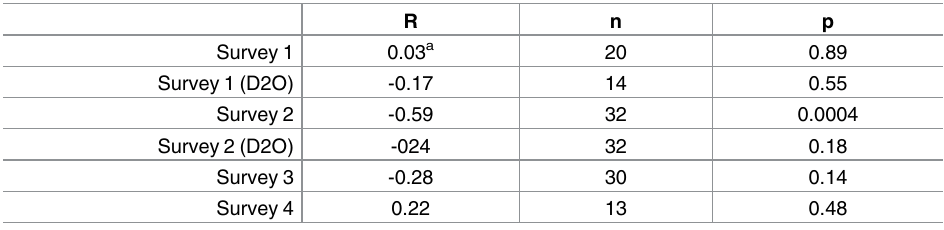
Table 1. Summary of correlations for FceRI density vs. spontaneous